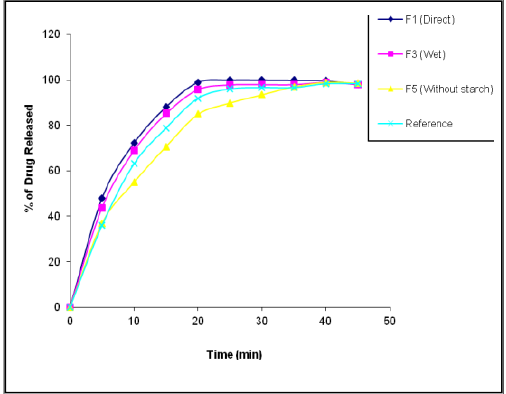
Figure 7: Effect of method of preparation and presence of starch on the cumulative release of Bisoprolol fumarate in a comparison with concor as a refrence in distilled water at 37 0 C